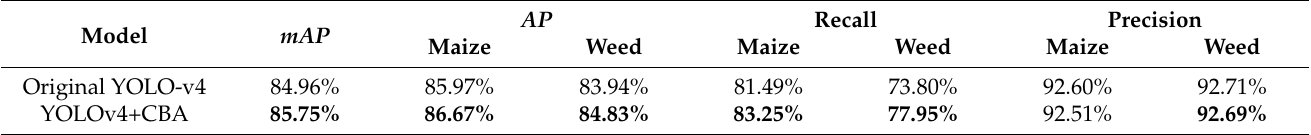
Table 3. CBA module ablation